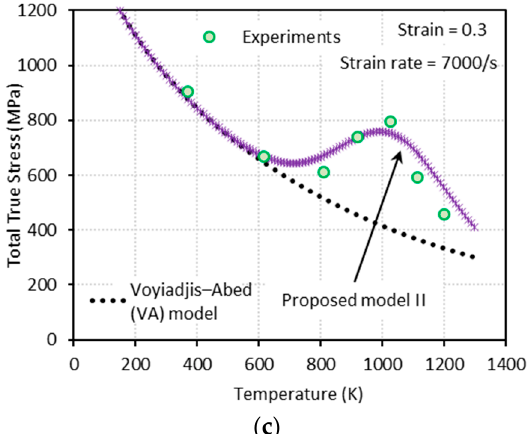
Figure 17. Comparisons between model predictions from the VA and proposed model II and experimental data from [1] on the total true stress versus temperature responses at ( a ) ε = 0.1, ( b ) ε = 0.2, and ( c ) ε = 0.3. Dynamic loading with 7000 s − 1 is applied.